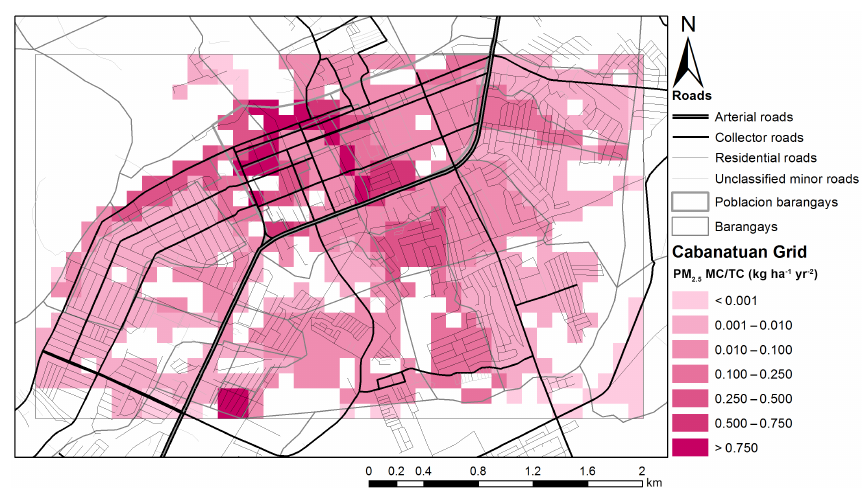
Figure 6. Map of estimated PM 2 . 5 emissions from motorcycles and tricycles. Base map derived from satellite imagery (Google Earth Pro, 2015, 2016).